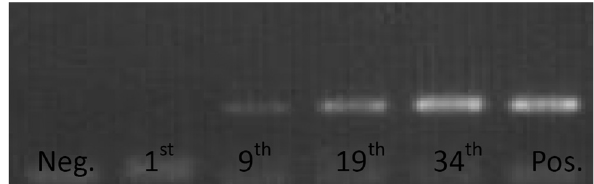
Figure 3 - The repeatability of using fecal DNA methylation status to identify CRC progression. Samples were taken at the indicated rat age.